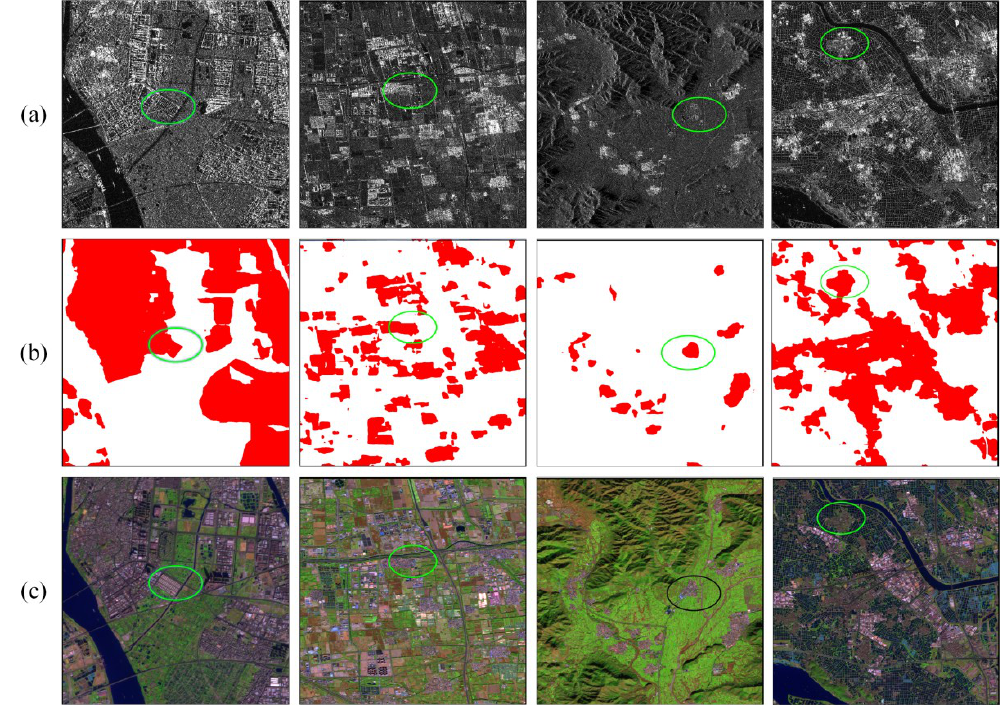
Figure 8. Detailed display of local extraction results. ( a ) GF-3 SAR image slices; ( b ) extraction results; and ( c ) corresponding Sentinel-2 image slices. Table 4. Accuracy evaluation of building-area extraction results in four regions.